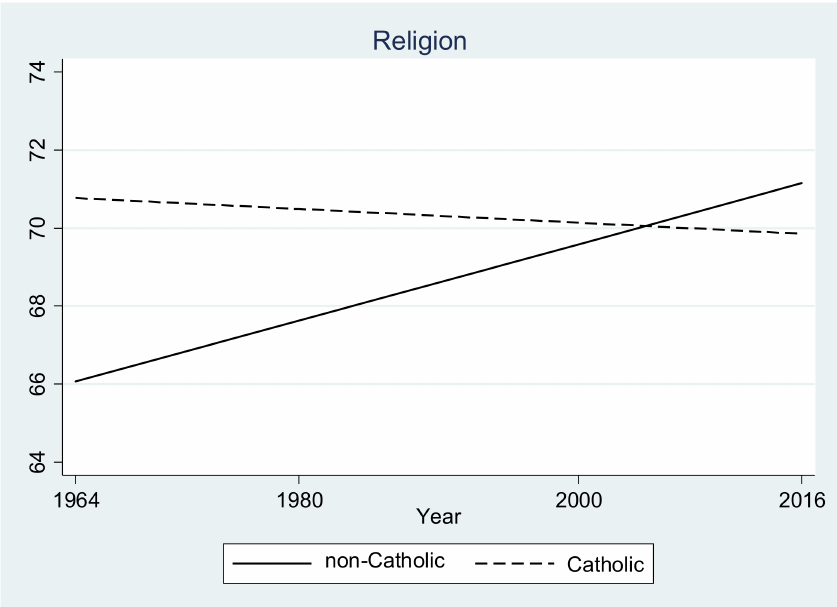
Figure 7. Impact of religion on the Jewish feeling thermometer, 1964–2016. Based on results from Table 3. Source: American National Election Studies,